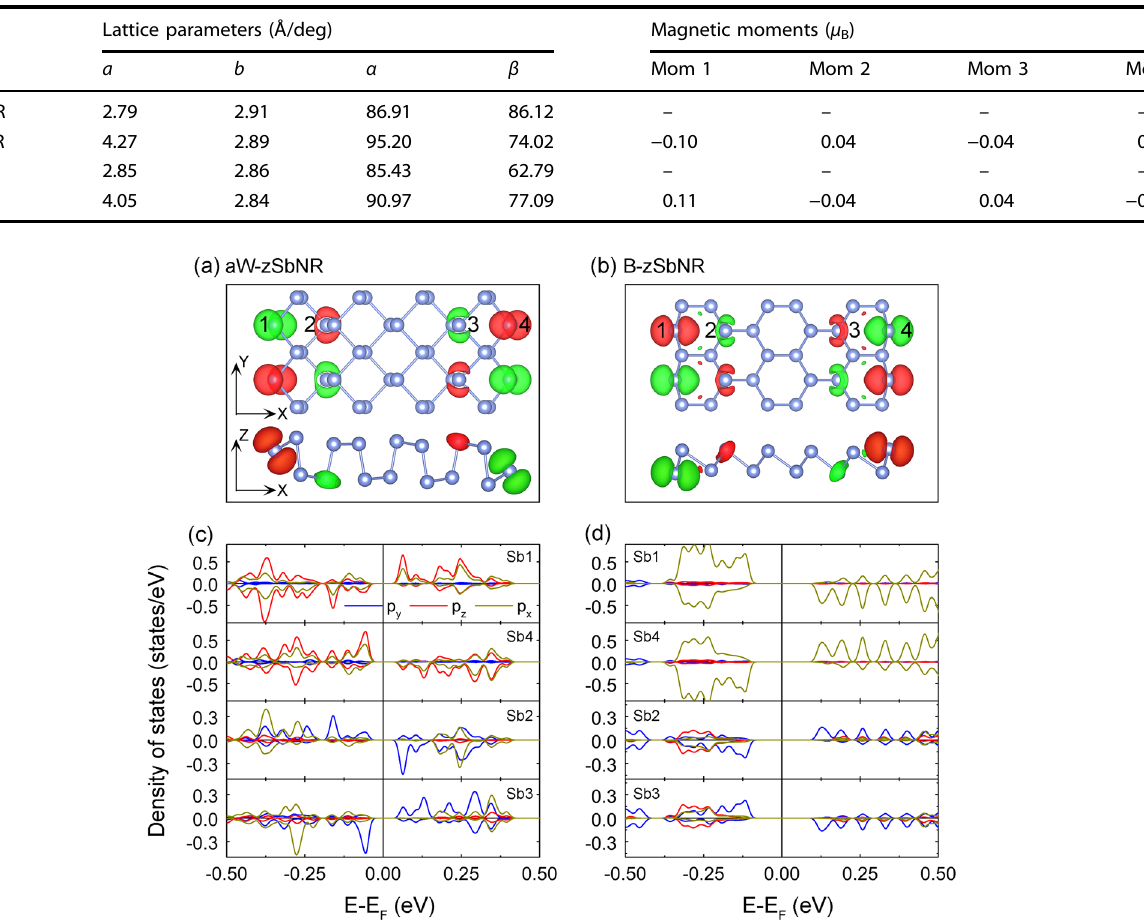
Fig. 2 Spatial spin density distribution ( ρ ↑ - ρ ↓ ) for a aW-zSbNR and b B-zSbNR: spin up, red ; spin down, green . The value of isosurface is 0.001 e/Å 3 . The orbital-resolved DOS for Sb1 ~ Sb4 atoms in a and b are plotted in c and d ,